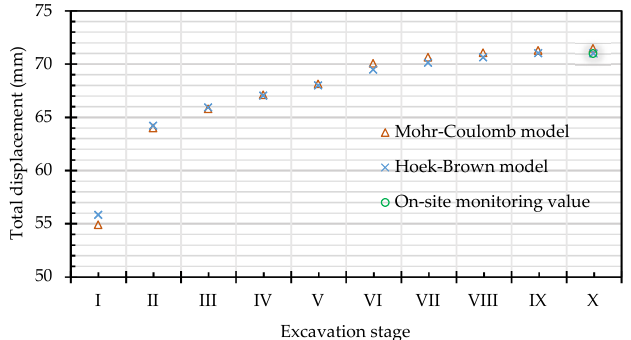
Figure 15. The total displacement of the tunnels in the Mohr–Coulomb model and the Hoek–Brown model with the excavation stage under biased pressure.